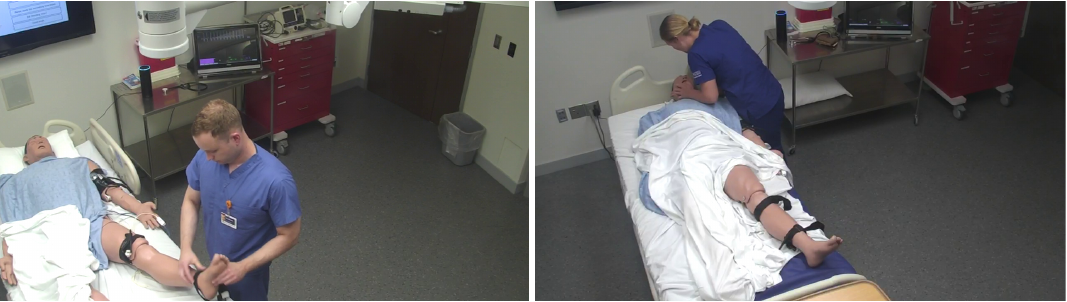
Figure 7. Experimental setup: participants treating manikin patient in Case 2 (reproduced from [5]).